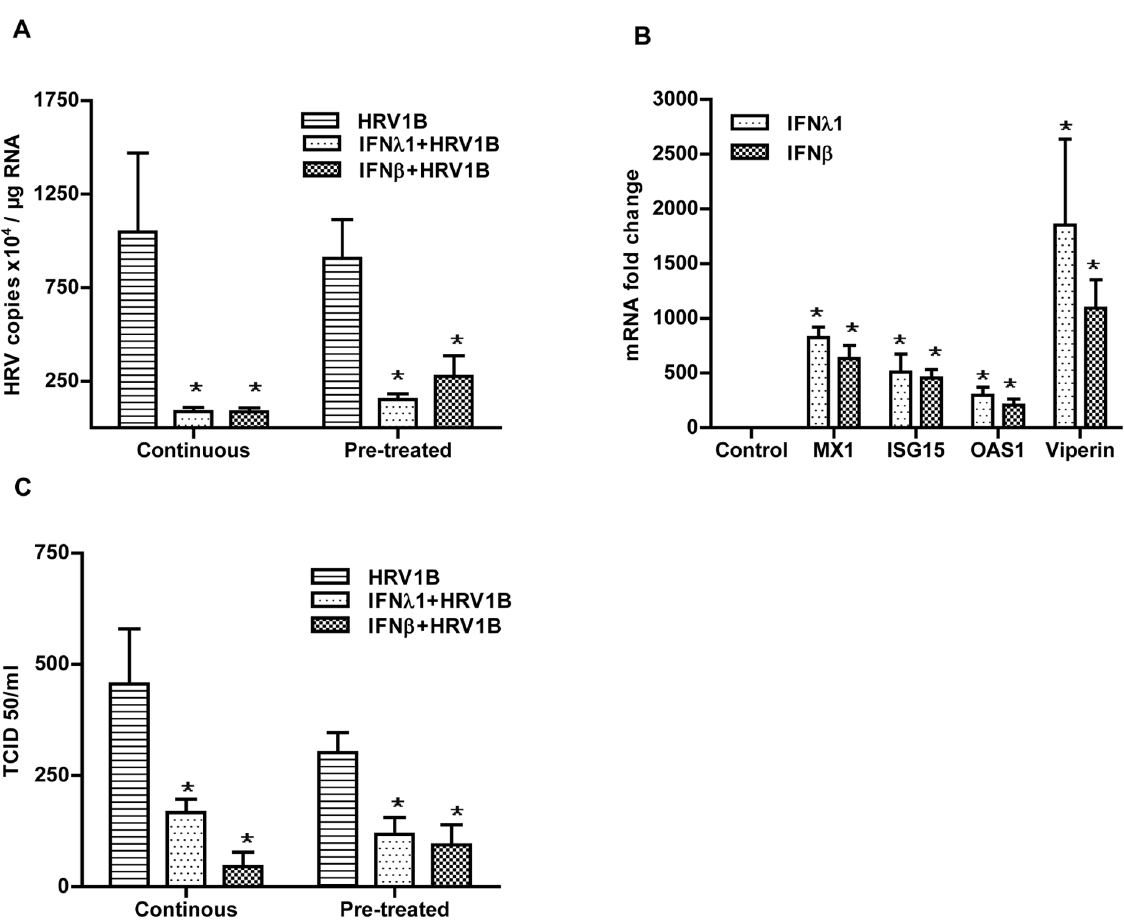
Figure 6. IFNs-induced antiviral state protects against HRV1B infection in PBECs. PBECs were infected with HRV1B for 4 h. After infection period, medium was either maintained on the cells (continuous) or replaced with fresh medium (pre-treated). After that cells were incubated for another 24 h. Then the supernatant was collected to determine TCID50 (C) while cells were collected to determine viral copies (A). PBECs were treated with IFNs for 18 h and then mRNA expression of different ISGs was determined by qPCR. Fold changes were calculated with the 2 2 DD Ct method (B). *, p , 0.05 control vs rest of the conditions n=4.